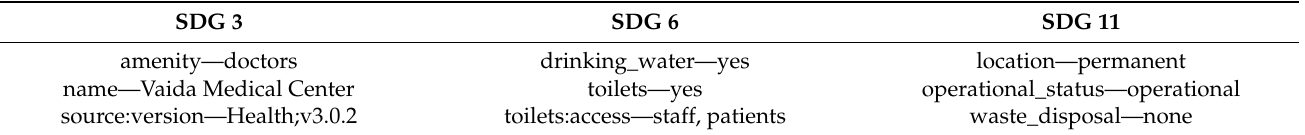
Table 2. Example of three Sustainable Development Goals (SDGs) and associated OSM tags (shown as “key—value” pairs) at Vaida Medical Center in Pagirinya Refugee Settlement in northern Uganda (OSM Node ID: 5789318243). SDG 3 SDG 6 SDG